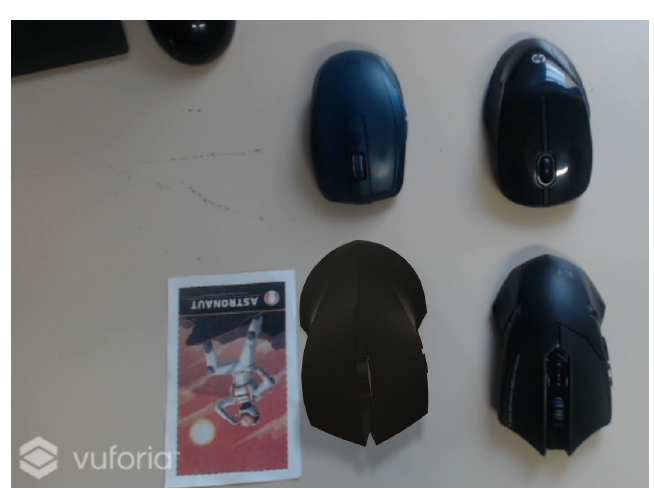
Figure 25. HoloLens shadow representation of a mouse (on the right).